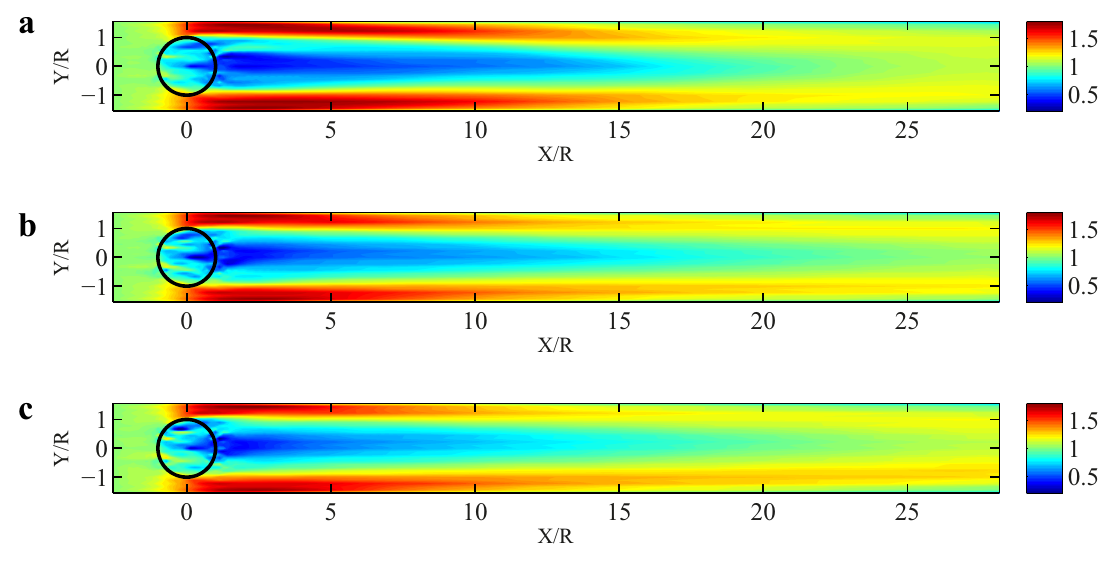
Figure 9. Contours of the normalized mean streamwise velocity, u/U at the equator height of the rotor for the actuator line model (ALM): ( a ) Smagorinsky model, Cs = 0 . 2 ; ( b ) Smagorinsky model, Cs = 0 . 1 ; ( c )